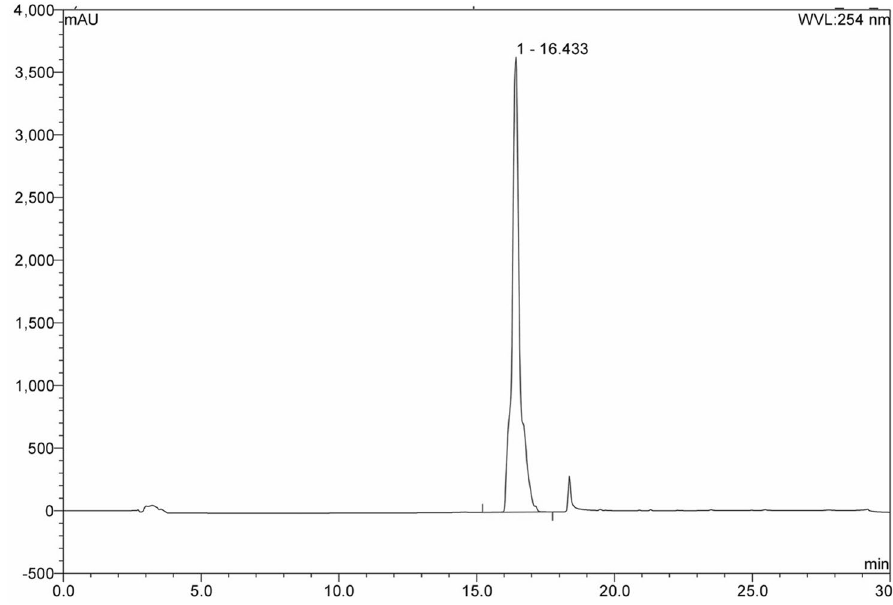
Figure 4. Figure showing UV/Vis peak for AVT-011 standard at 16.4 min.